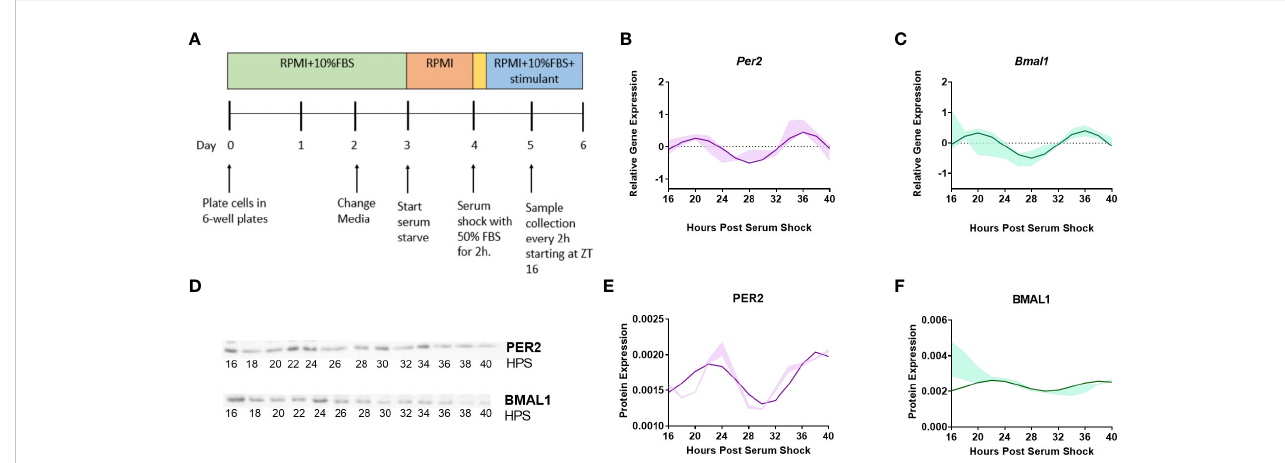
FIGURE 1 Clock genes Per2 and Bmal1 display circadian oscillations in resting BV2 microglia. (A) BV2 microglia were synchronized using the serum-shock protocol and samples were collected every 2 h starting at 16 h post serum-shock (HPS16) for RT-qPCR and Western blotting experiments. (B, C) ECHO fi tted plots for mRNA expression of clock genes Per2 and Bmal1 in BV2 microglia. Data represented as fold change in expression using Hprt1 as a reference gene and HPS0 as a reference sample for the DD Ct method of data analysis (n = 3) (D) Time course samples obtained from serum-shock synchronized BV2 cells analyzed using Western blotting to measure the levels of PER2 and BMAL1. Amido black staining was used to normalize for protein loading. For complete blot images refer to Supplementary Information (Supplementary Figures 3, 4) (E, F) ECHO fi tted plots for PER2 and BMAL1 protein levels in BV2 cells (n = 3). For all ECHO plots, the bold lines depict the ECHO fi tted model and the shaded region represents ±1 standard deviation of model at each time point. Statistical signi fi cance was determined using ECHO. All plots had p < 0.05 for ECHO signi fi cance fi